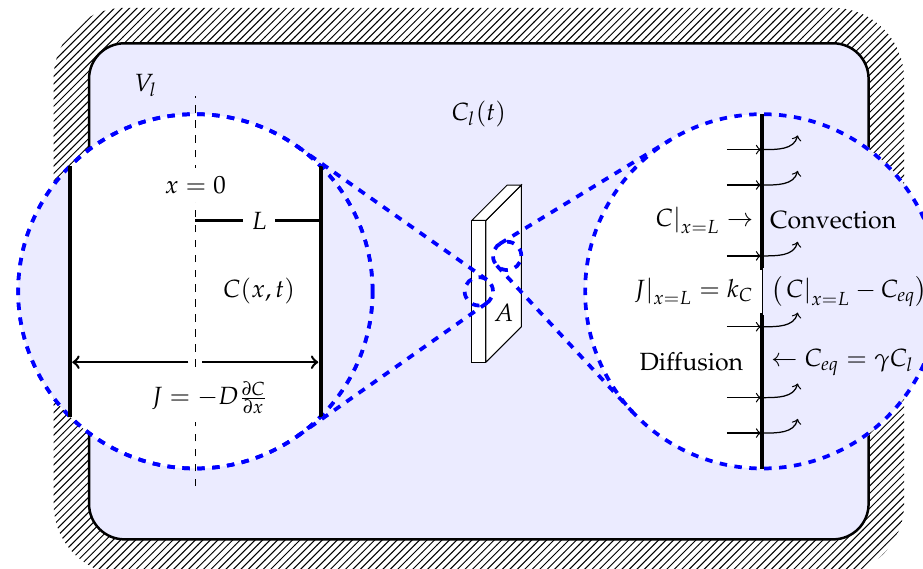
Figure 1. Scheme of the drug delivery